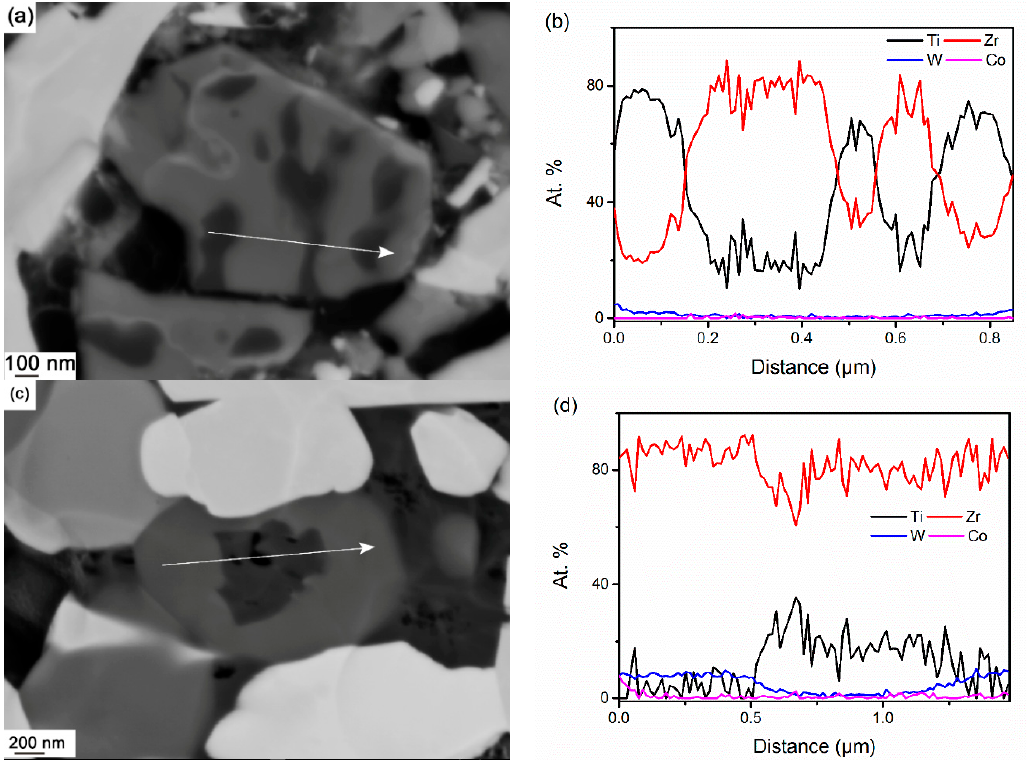
Figure 7. EDS line scan ( a , b ) across a (Ti,Zr)C lamellae in composite 1 interruptedly sintered at 1310 °C, ( c , d ) through γ 2 with dark core in fully sintered composite 1.